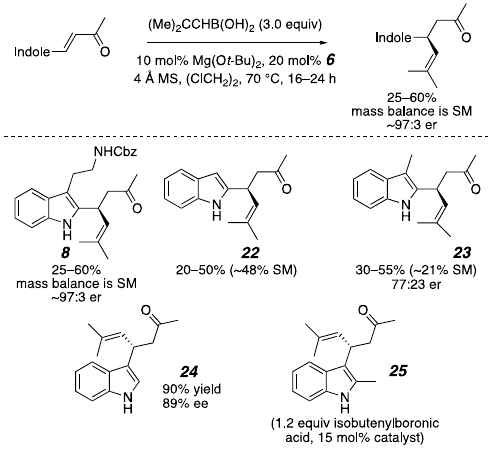
Figure 5. Indole control experiments.